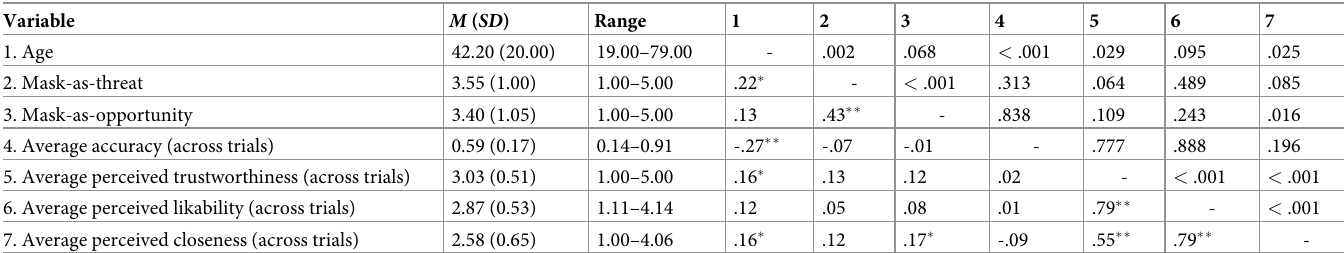
Table 1. Associations between all continuous variables included in the